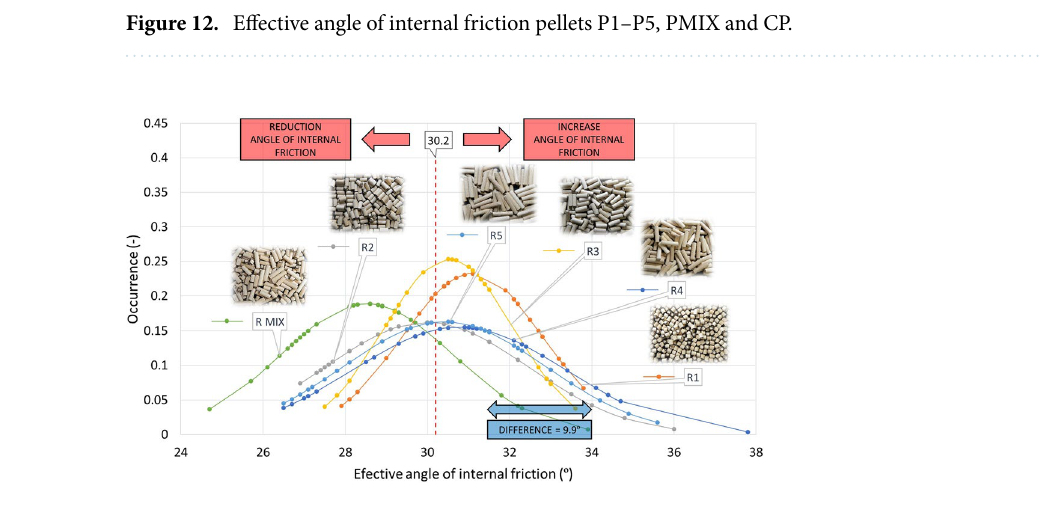
Figure 13. Effective angle of internal friction pellets R1–R5 and